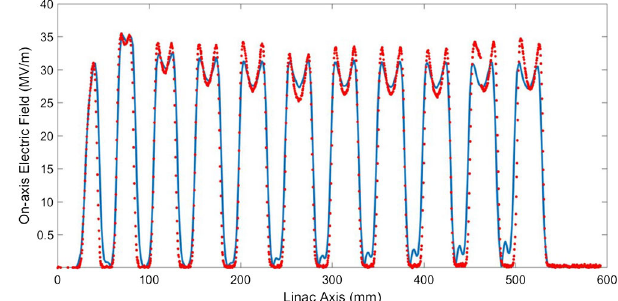
16. On-axis electric field. The measured field profile (solid blue line) measured by means of the bead-pull technique shows good agreement with the field simulated with CST (dotted red line).